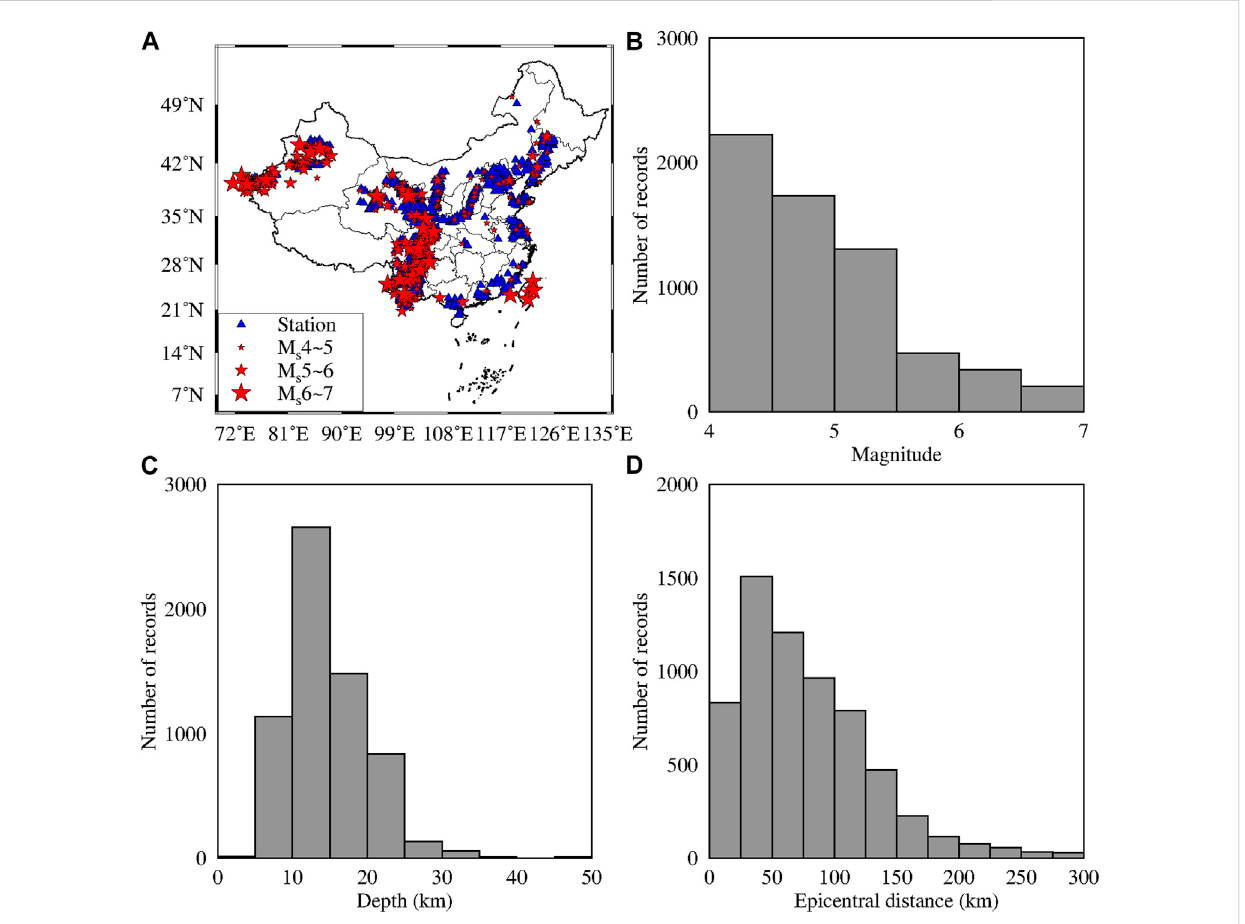
FIGURE 1 (A) Thedistributionofepicentersandstationsinthedatasetofthispaper. (B) Therelationshipbetweenthemagnitudeandthenumberofrecords. (C) The relationship between the depth and the number of records. (D) The relationship between the epicentral distance and the number of